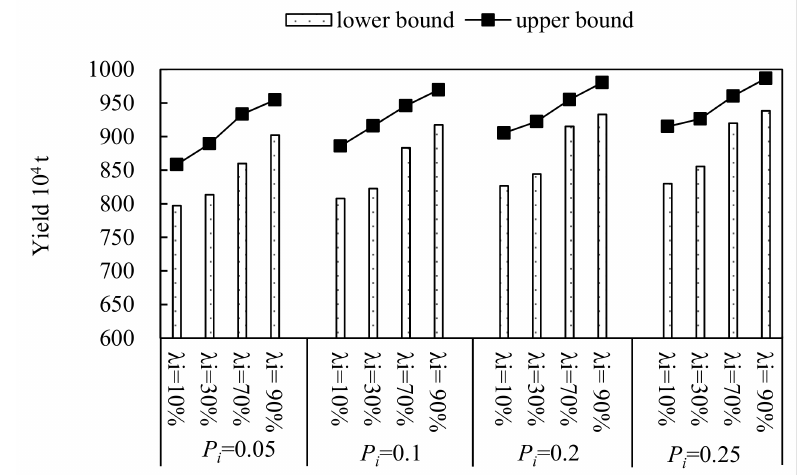
Figure 5. Yield of di ff erent water-saving modes under di ff erent violation probabilities, P i .